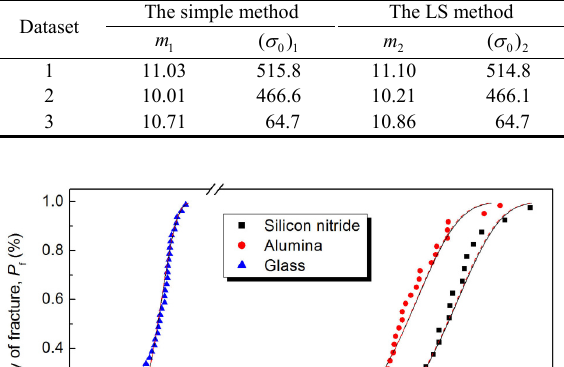
strength size effect in polycrystalline silicon using the three-parameter Weibull function. J Am Ceram Soc 2014,